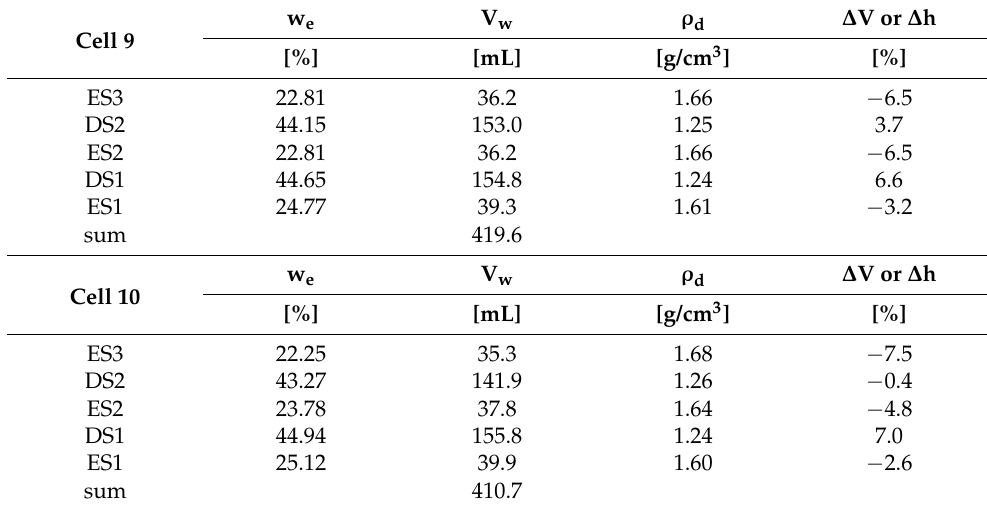
Table 5. Water content (200 ◦ C) (w e ), volume of water (V W ), dry density and volume (height) change after dismantling of cell 9 and